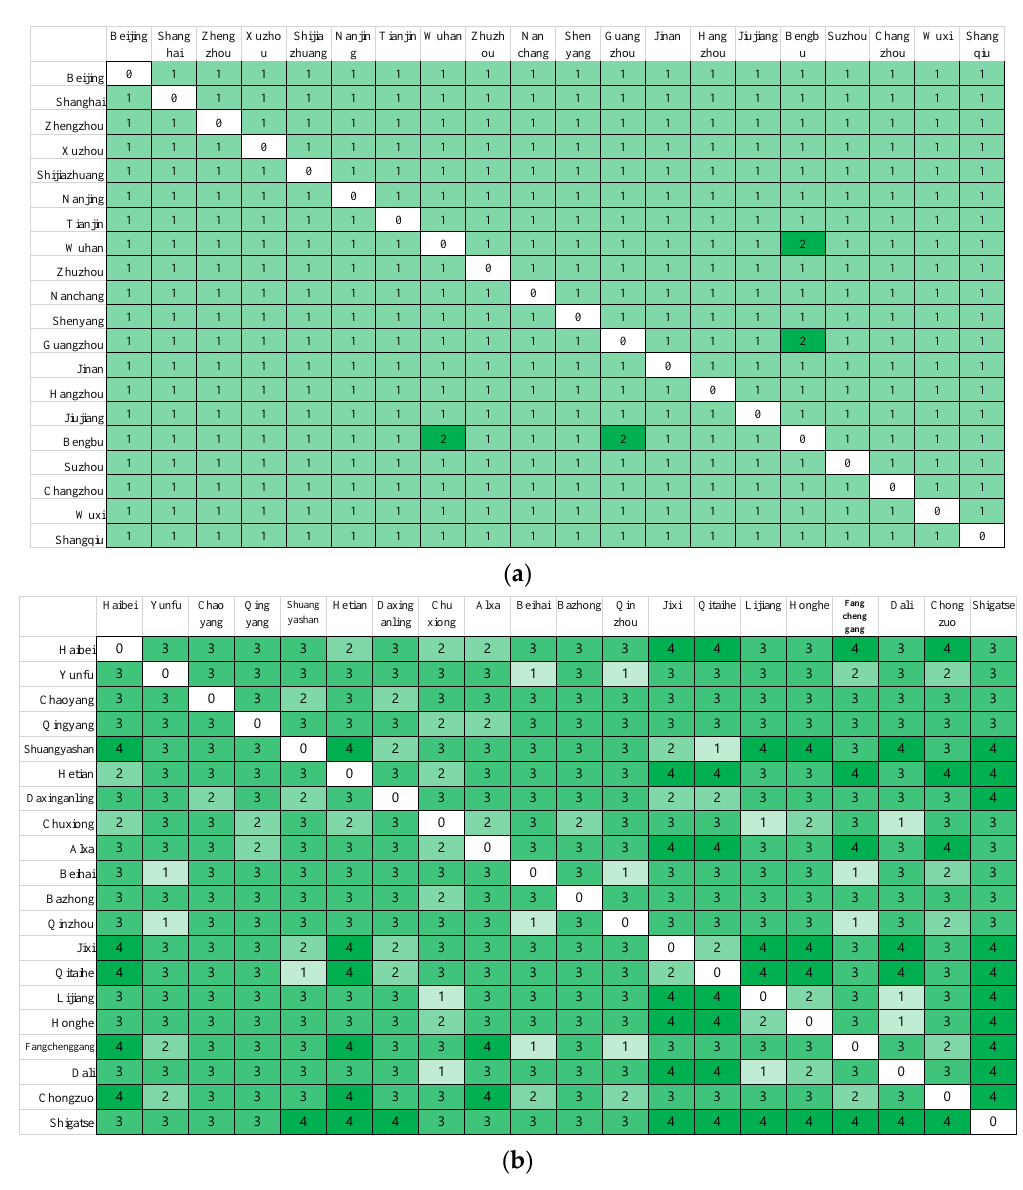
Figure 5. Shortest distance between pairs of ( a ) top and ( b ) bottom 20 cities in terms of DC (the digits in each cell show the number of edges along the shortest path between city pair; the larger the cell value, the darker the cell color).